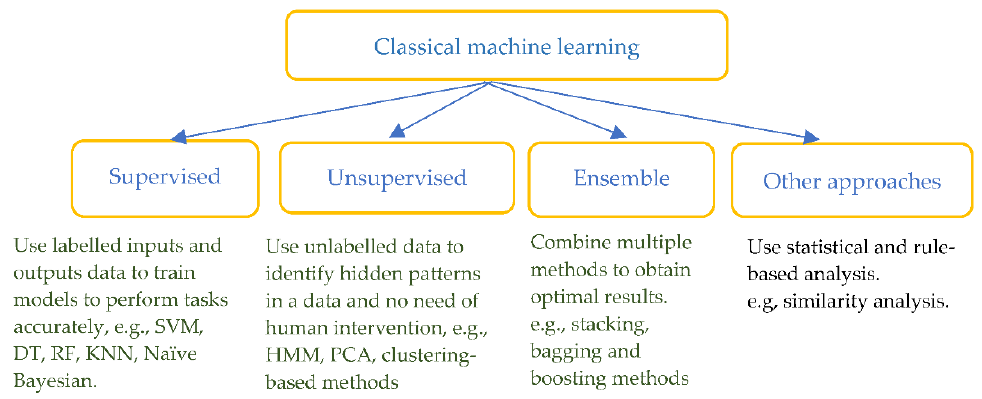
Figure 4. Classification of classical machine learning methods.